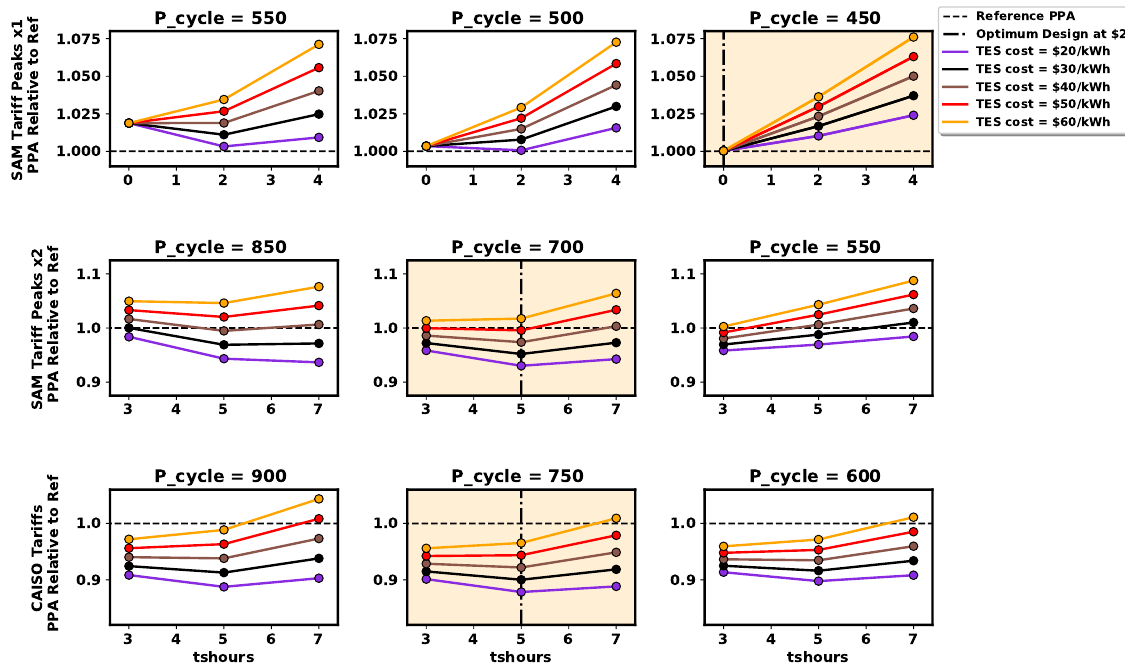
Figure 12. Sensitivity of PPA price to TES cost. Plots are arranged by different market scenarios in the rows and power cycle outputs in the columns. Individual plots show PPA price relative to the reference design performance (marked as a horizontal line at a value of 1.0) as a function of thermal storage hours. Multiple lines are shown per plot for varying TES cost. Optimal design points are highlighted for each market scenario: the optimal electrical output column is highlighted by face color and the corresponding storage size is marked by a vertical